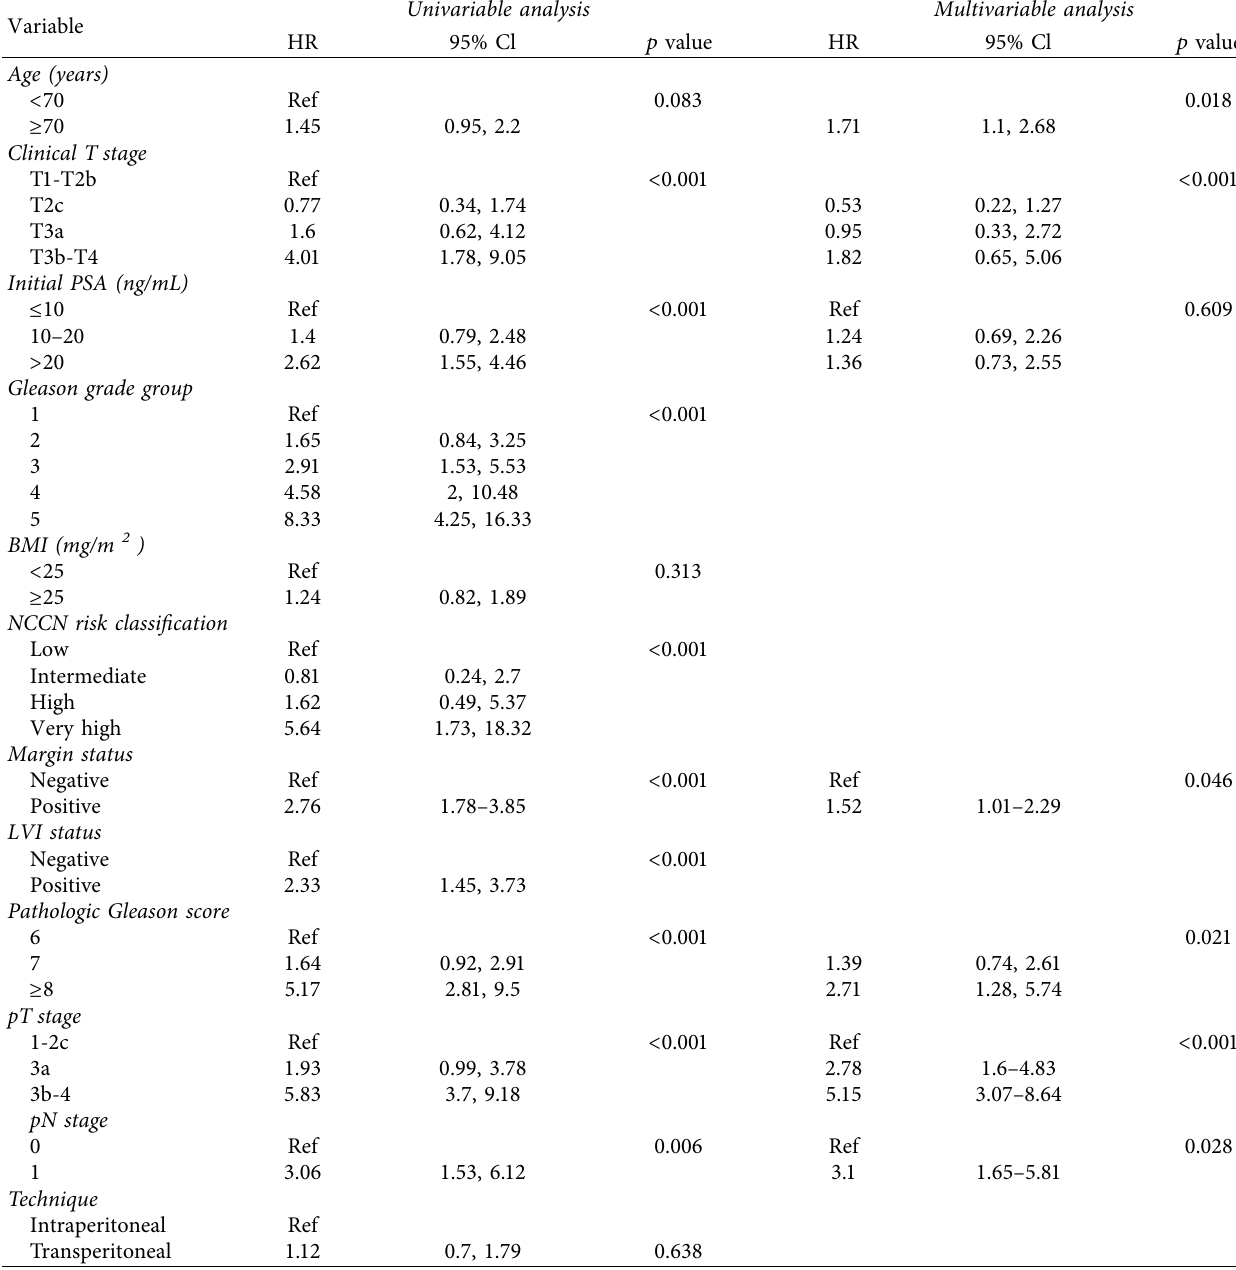
Table 6: Cox univariable and multivariable